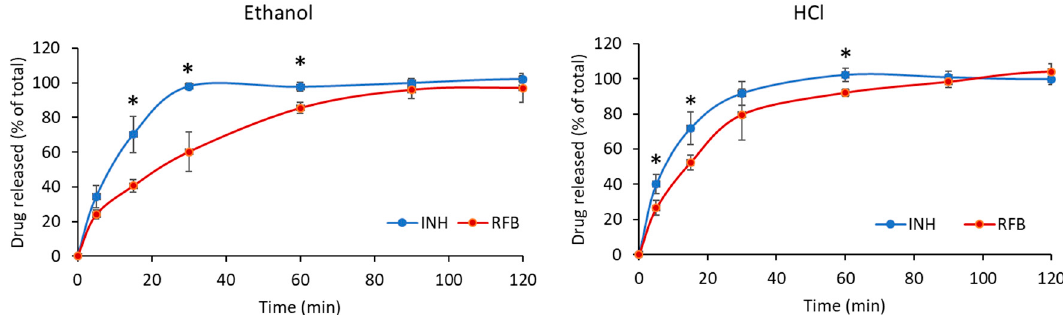
Figure 5. In vitro release of isoniazid (INH) and rifabutin (RFB) from ChS / INH / RFB (10 / 1 / 0.5, w / w ) microparticles in PBS pH 7.4-Tween 80 ® , at 37 °C (mean ± SD, n = 3). * p < 0.05 comparing INH and RFB at a given time point.